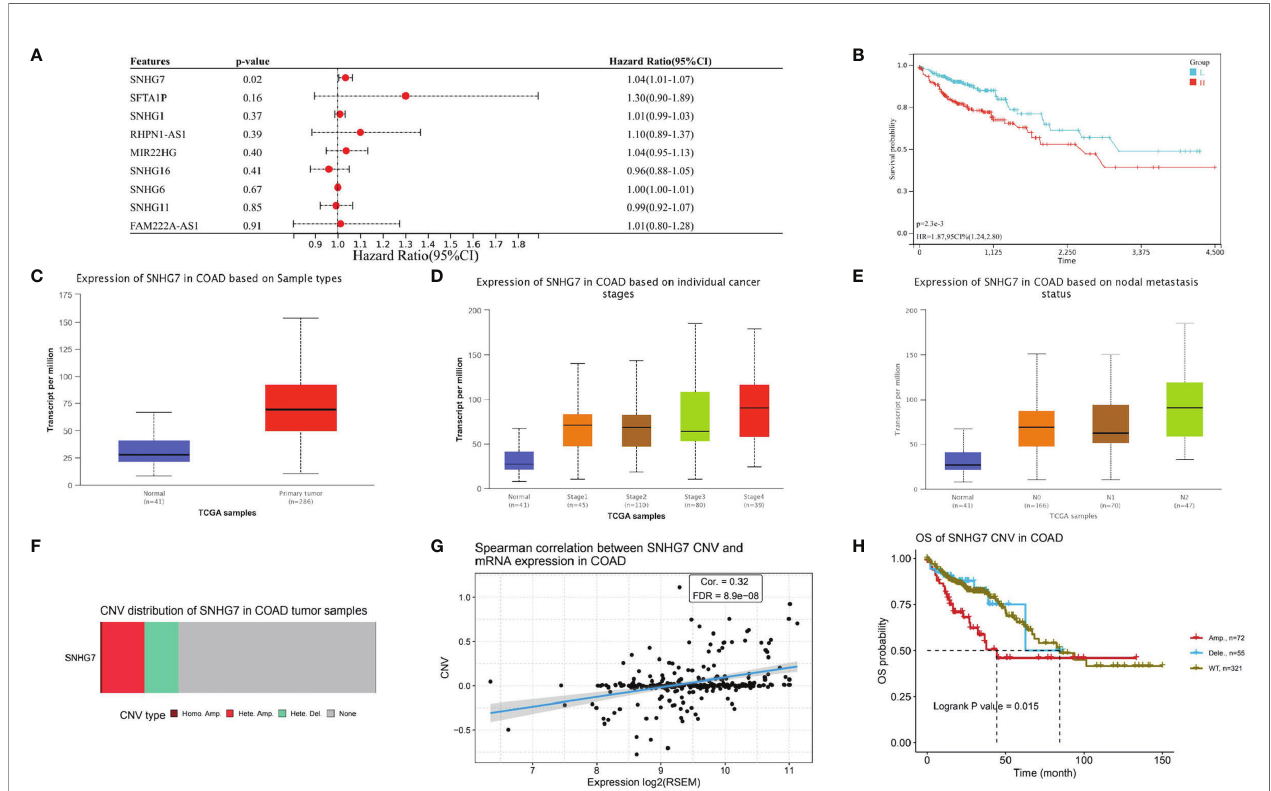
FIGURE 6 | Survival, Expression, and Mutational Analysis of lncRNA SNHG7 in COAD. (A) Forest plot showing the results of multivariate Cox regression analysis of 9 lncRNAs and overall survival in COAD patients. (B) Kaplan-Meier survival analysis of SNHG7. (C) SNHG7 expression in COAD. (D, E) The relationship between SNHG7 expression in COAD with tumor stage and lymph node metastasis. (F) Copy number variation (CNV) type distribution of SNHG7 in COAD. (G) Correlation between SNHG7 CNV and expression in COAD (H) Overall survival of SNHG7 CNV in